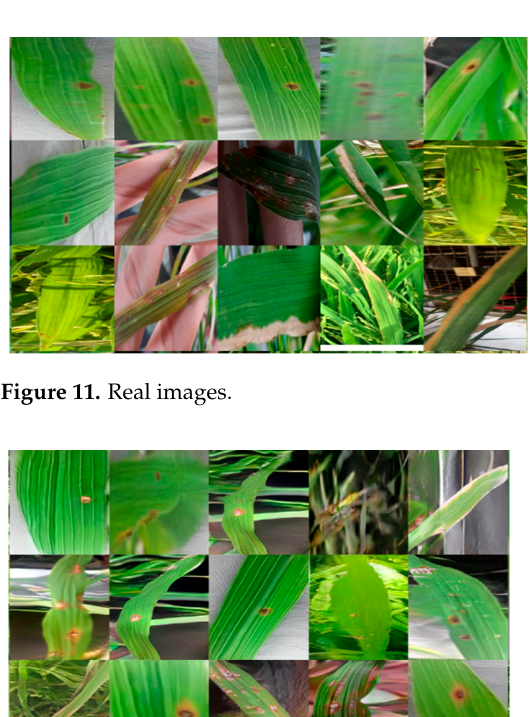
Table 2. Results of the SG2-ADA.